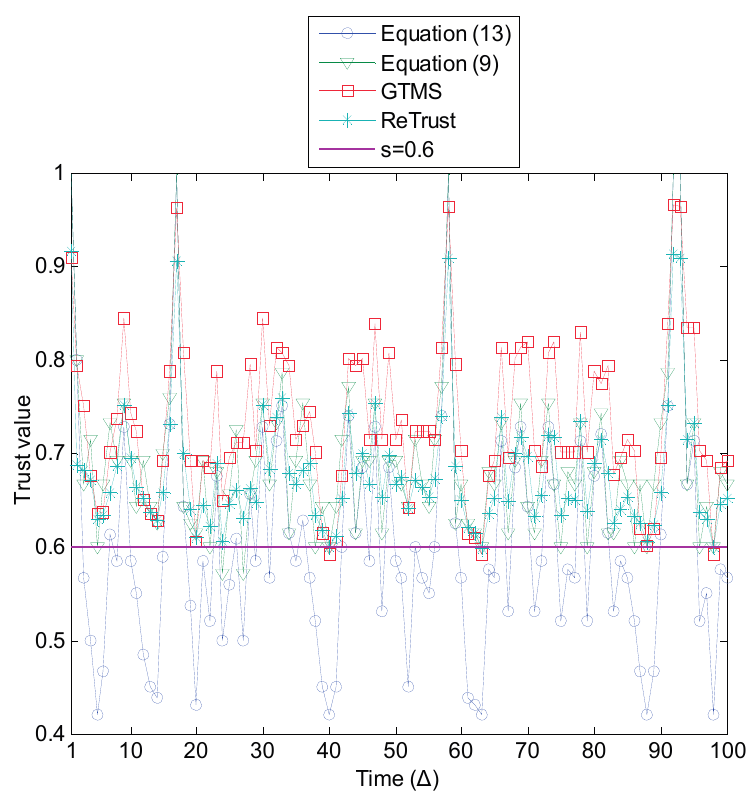
Figure 9. On-off attack detection (probability of an on period is 0.6).